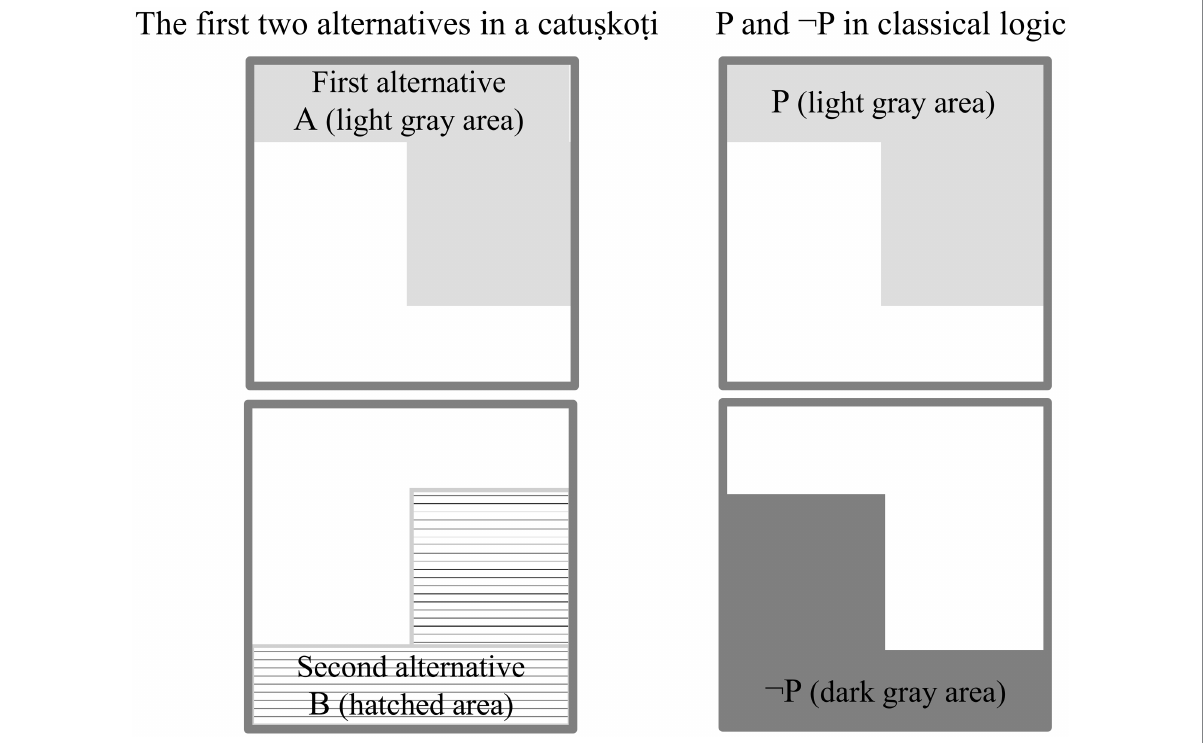
FIGURE 2 Comparison of the first two alternatives (A, B) in a catus ̣ kot ̣ i and a contradictory pair of propositions (P and ¬P) in classical